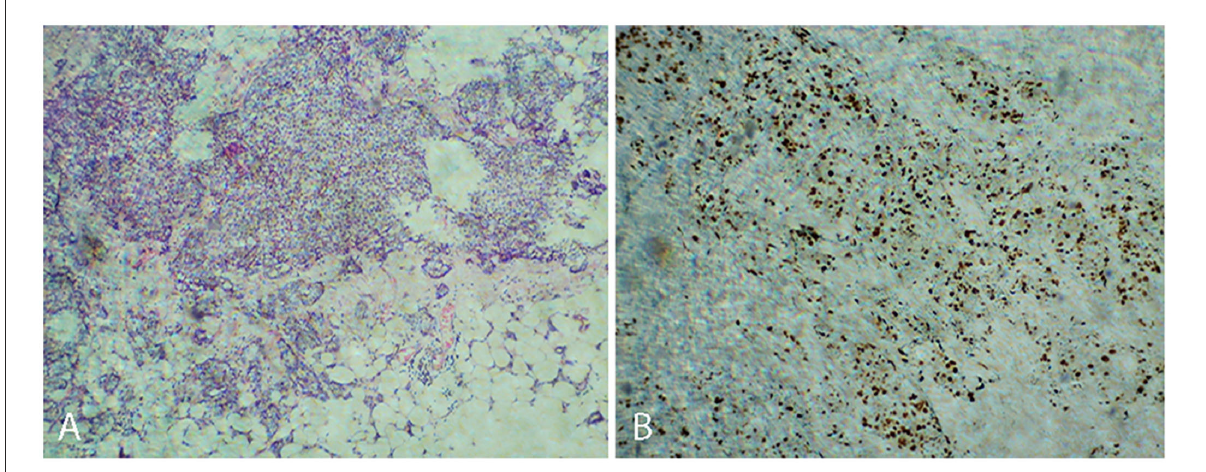
FIGURE1 Non-specific invasive carcinoma of the right breast (invasive ductal carcinoma SBR II-III) (A) . Positive immunohistochemical staining for Ki 67 (B) .